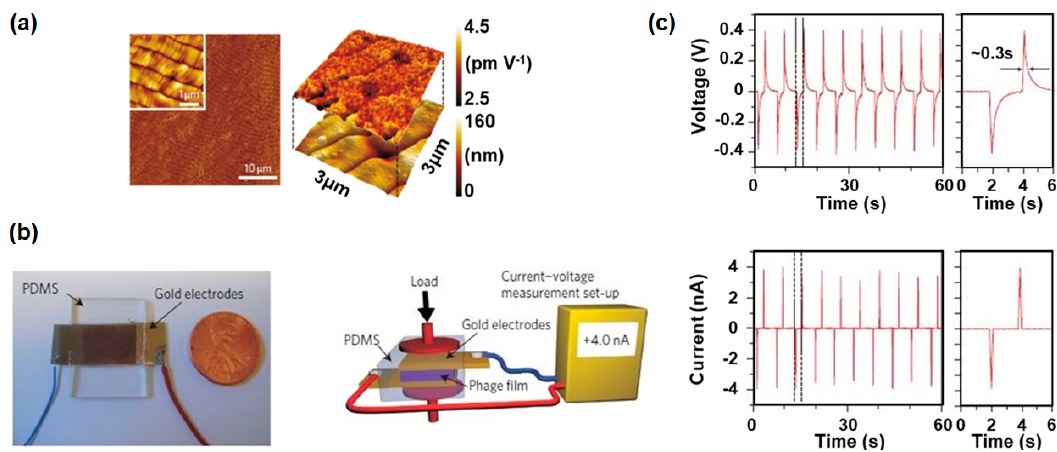
Figure 5. Characterization of an M13-bacteriophage-based piezoelectric energy generator (drop-casted